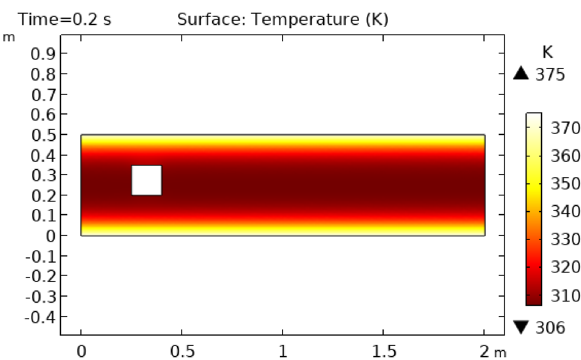
Figure 10. Surface Temperature in squared cylindrical flow at t = 0.2 s.